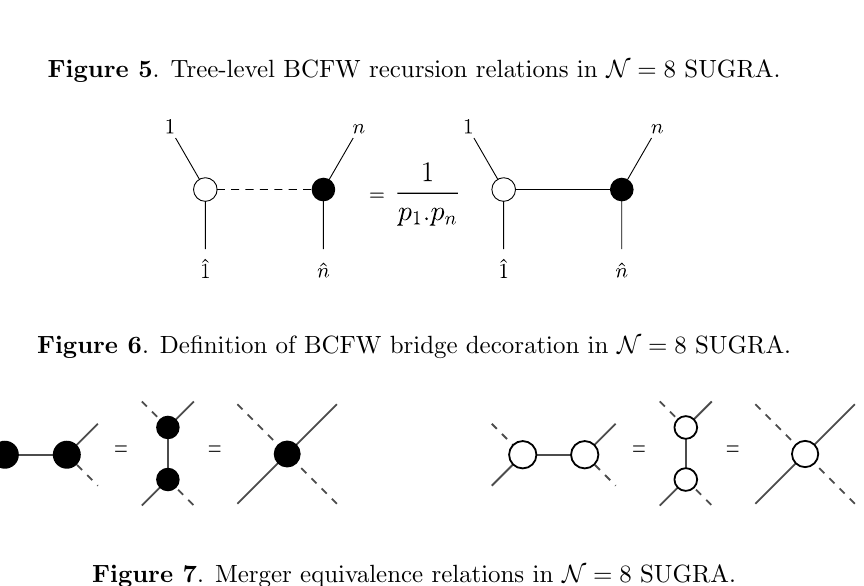
Figure 7 . Merger equivalence relations in N = 8